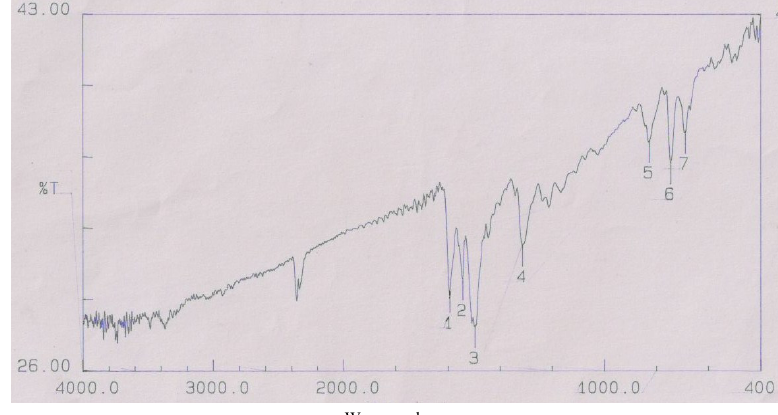
Figure 3. FTIR spctrum for BF